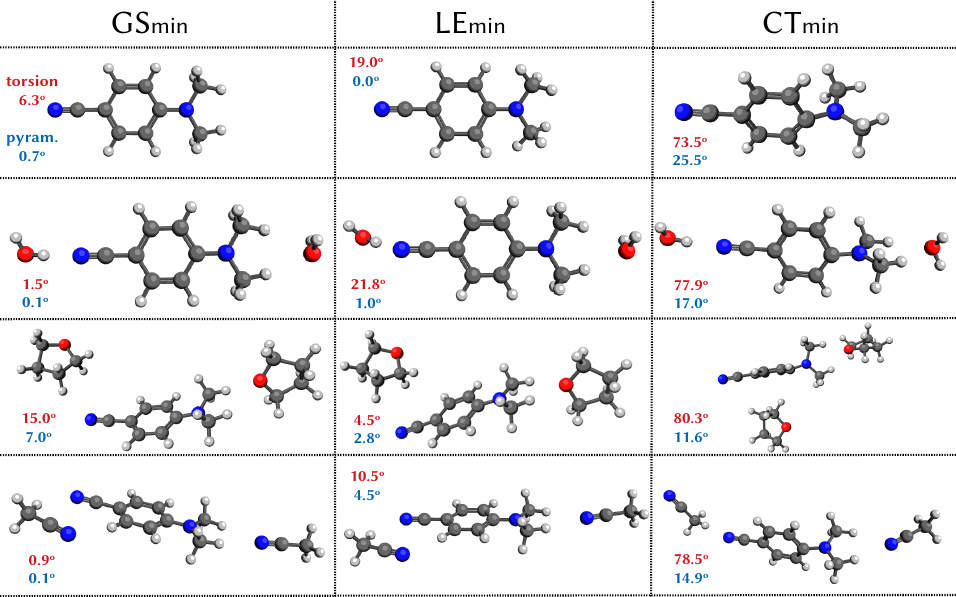
Figure 2. Optimised structures for the ground state (GS), local excited state (LE) and intramolecular charge transfer state (CT) of DMABN in the gas phase and in the micro-solvated clusters (water, acetonitrile and tetrahydrofuran) calculated with TDA-wB97X-D3/LR-CPCM/cc-pVDZ. The value in red for each structure is the torsion of the dimethyl-amino unit relative to the ring, and the value in blue is the pyramidalisation angle of the amino nitrogen relative to the ring